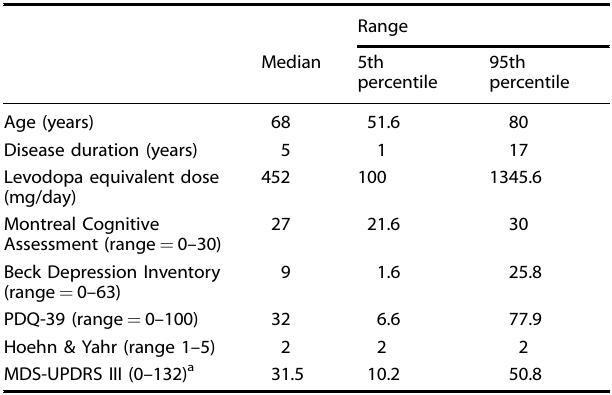
Table 1. Demographic details of the